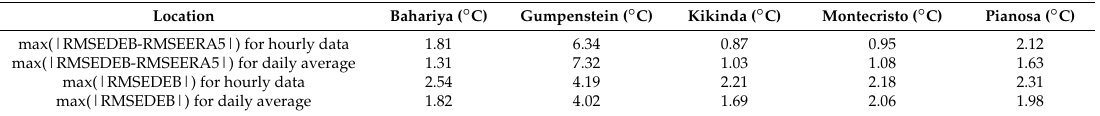
Table 3. Maximum absolute values of (RMSE DEB -RMSE ERA5 ) difference and RMSE DEB calculated using hourly and daily data for gap